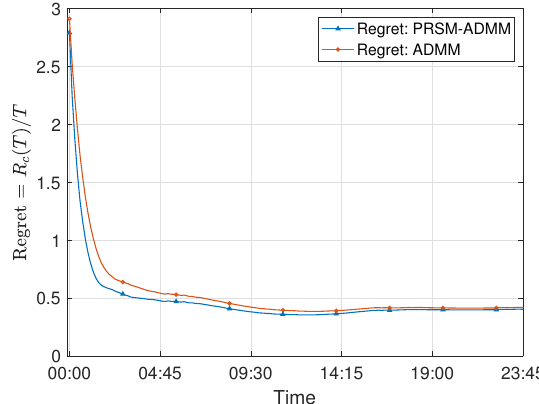
Figure 10. Regret bound of distributed online